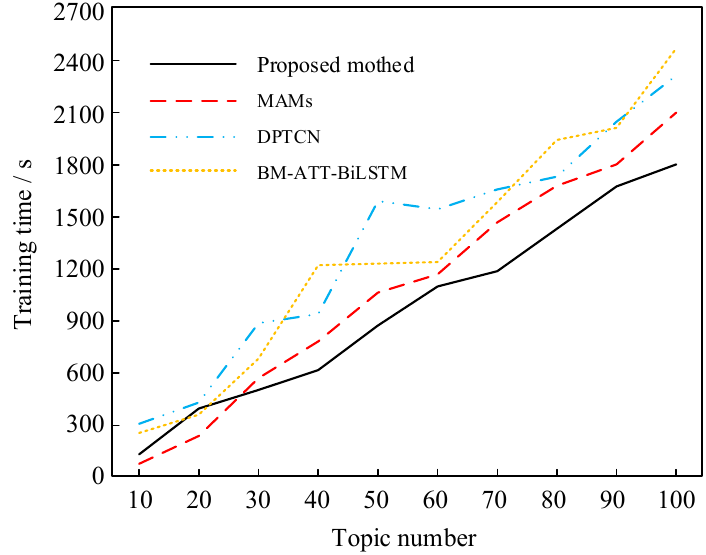
Figure 10. Training time of different methods under CNT dataset.